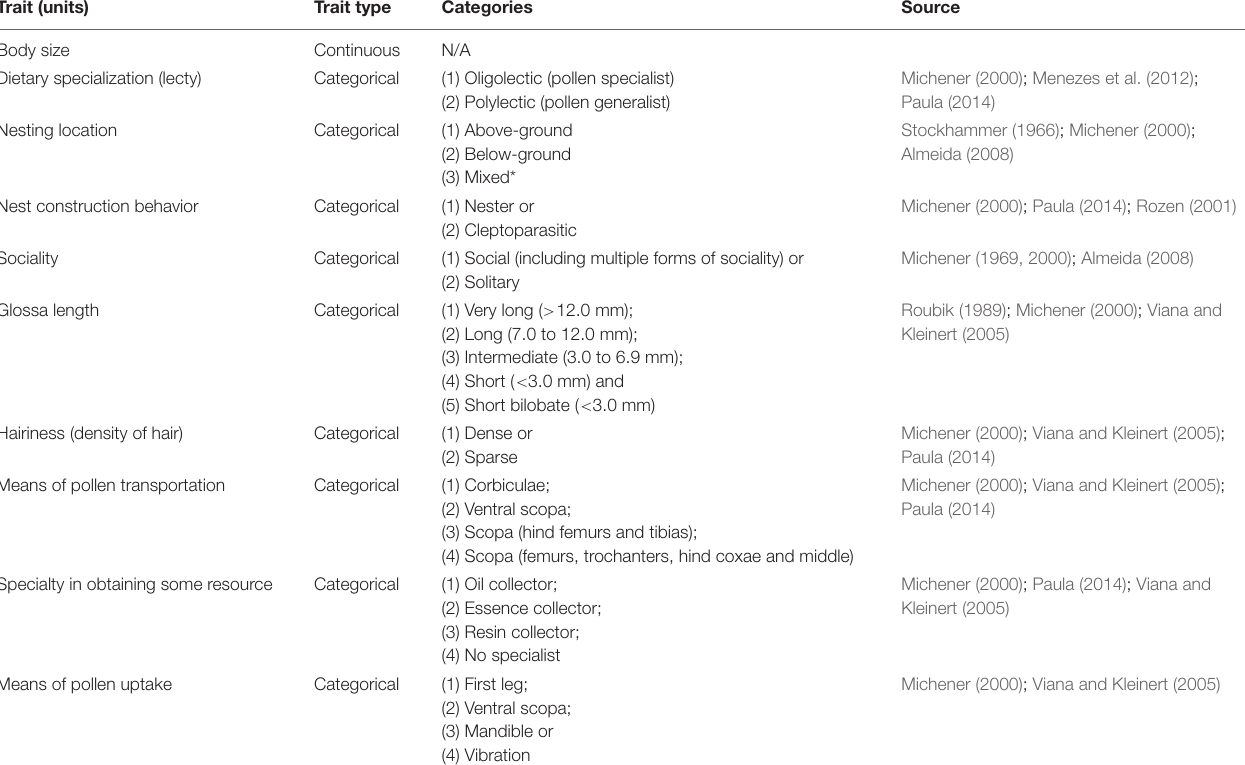
TABLE 1 | Traits used in analyses of functional richness, functional divergence, and functional